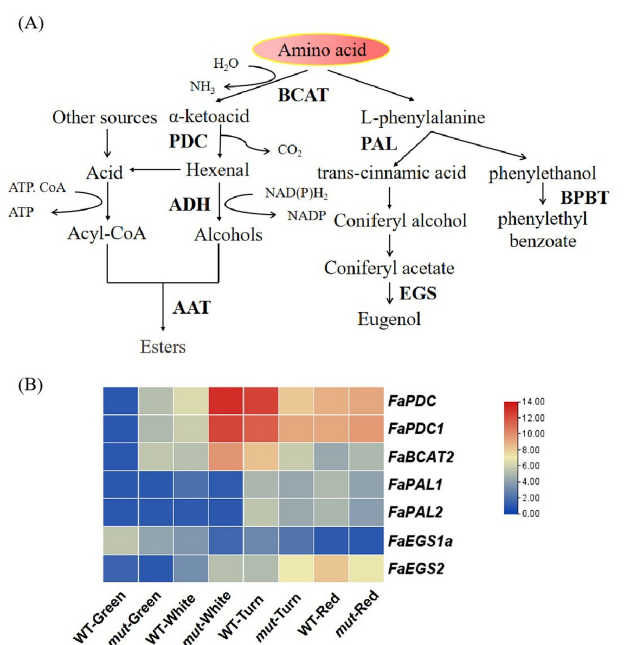
Figure 5. Amino acid pathway analysis. ( A ) Schematic diagram of the amino acid pathway. Multiple enzymatic reactions are illustrated by stacked arrows. Abbreviations: BCAT: branched ‐ chain amino